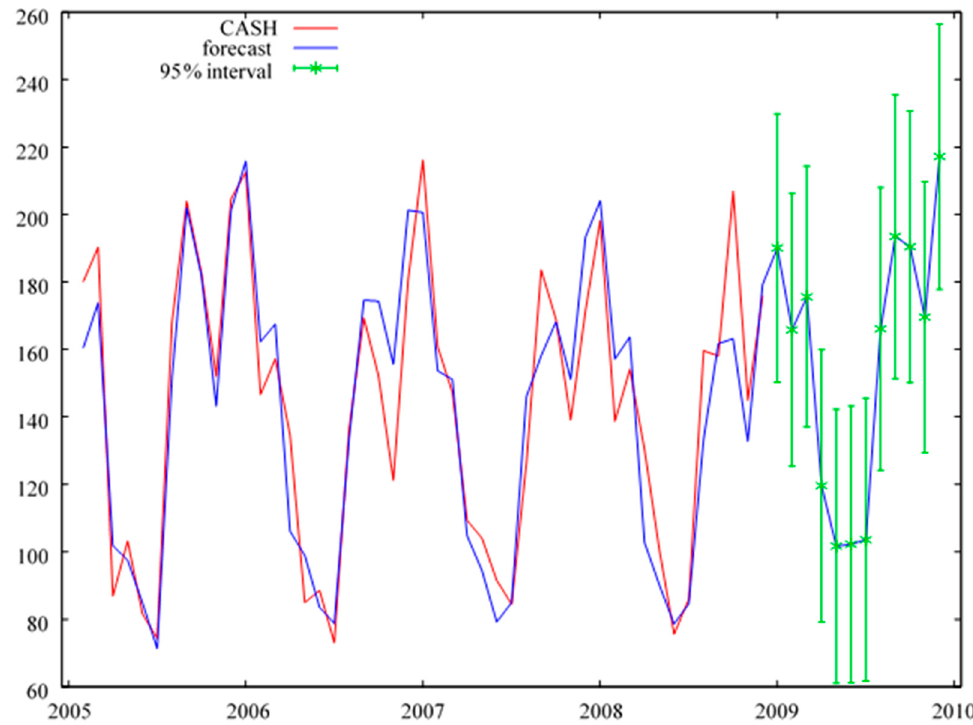
( s ) for the year 2009, in a system with an increase in the initial value CASH for the year 2009, in a system with an increase in the initial Tp CASH for the year 2009, in a system with an increase in the initial Tp Tp